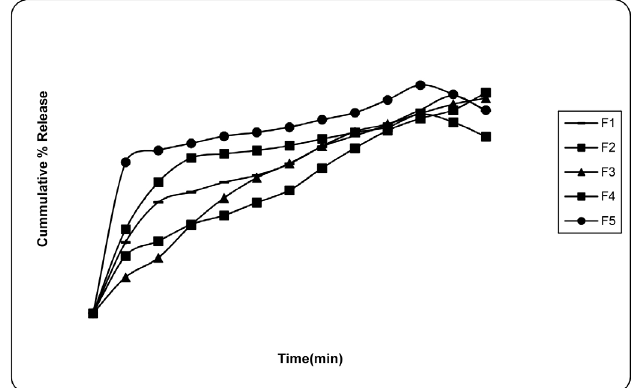
FIGURE 4 - Comparative results of in vitro release profile of different proportions of SA, CH, and SCMC beads of sodium diclofenacin phosphate buffer pH 7.4.